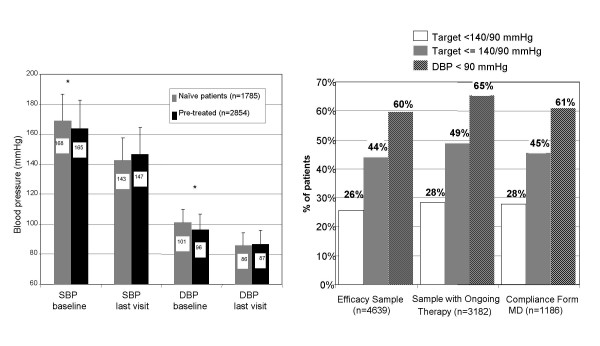
a. Evolution of blood pressure during observation period (~4 months): Efficacy Sample. Baseline SBP (systolic blood pressure): previously untreated patients 168.8 mmHg, pre-treated 163.5 mmHg (*p < 0.0001); SBP at last visit: previously untreated 142.8 mmHg, pre-treated 146.9 mmHg (p < 0.0001). Baseline DBP (diastolic blood pressure): previously untreated patients 101.2 mmHg, pre-treated 96.3 mmHg (*p < 0.0001); DBP at last visit: previously untreated 85.9 mmHg, pre-treated 86.8 mmHg (p = 0.004). b. Reaching of therapeutic targets: Efficacy Sample. Response to treatment is defined as reaching DBP < 90 mmHg or a reduction of DBP = 10 mmHg. In real-life practice, a satisfactory objective is also the normalization of DBP (< 90 mmHg). Target = 140/90 mmHg was introduced because of digit preference of study GPs (see results).